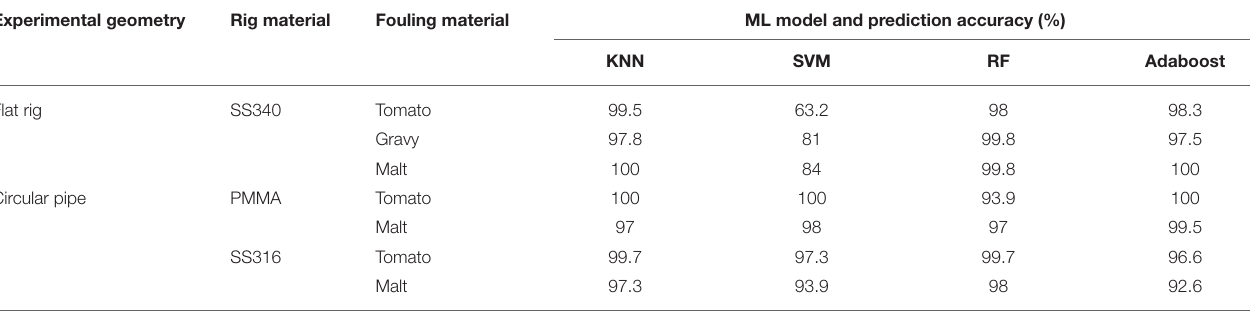
TABLE 3 | Comparison of classification prediction accuracy for different fouling materials, experimental geometry, material of construction, and ML method for test runs at 45 ◦ C. Experimental